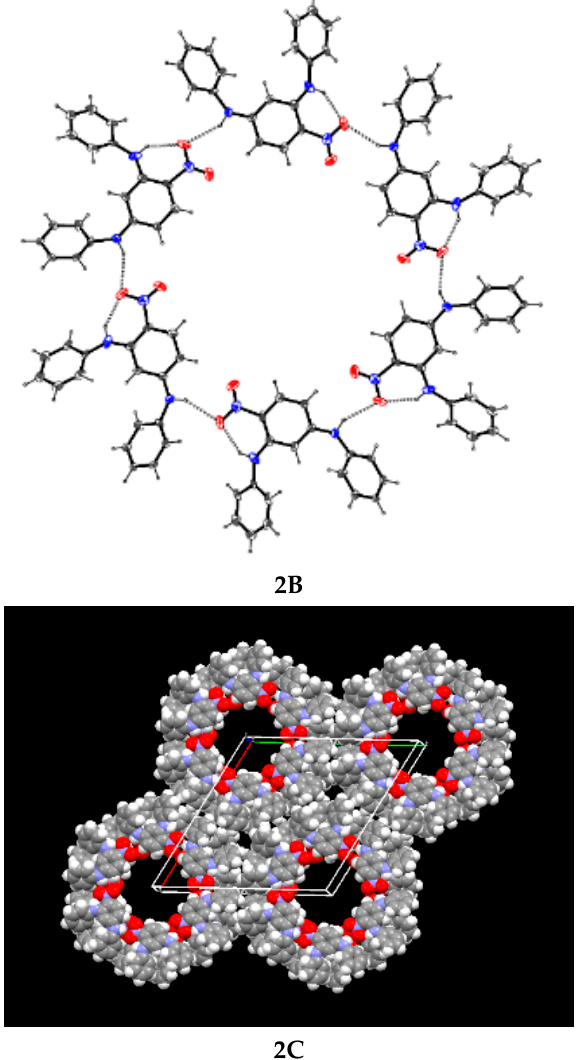
Figure 2. 2A Drawing of 2,4-(phenylamino)nitrobenzene; 2B A cross section of the crystal structure showing the hexameric hydrogen-bonded units of compound 2 leaving a large hole or channel; 2C Packing diagram of compound 2 showing the large pores.